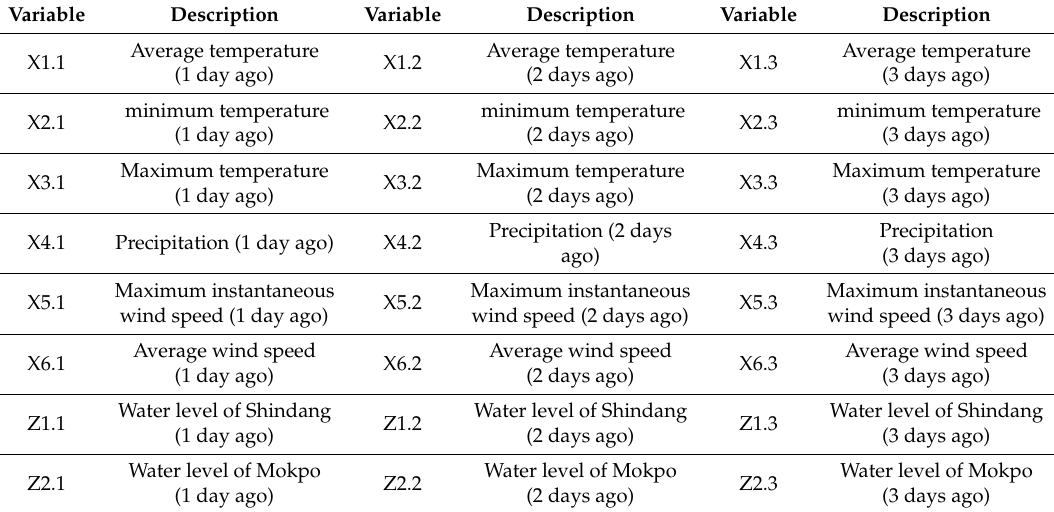
Table 2. List of independent variables used in this